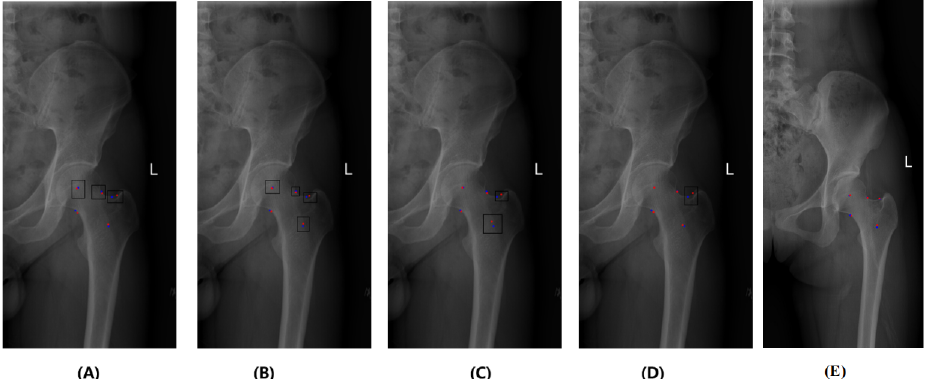
Figure 8. Landmark detection examples on hip radiograph images. The blue points represent the ground truth, and the red points represent predition from different models: column ( A ), Unet4; column ( B ), Unet4 (Fast-KD on UNet5); column ( C ), Unet4 (FSF-LD on UNet5); column ( D ), Unet4 (Fast-KD on SEG-UNet5); column ( E ), Unet4 (FSF-LD on